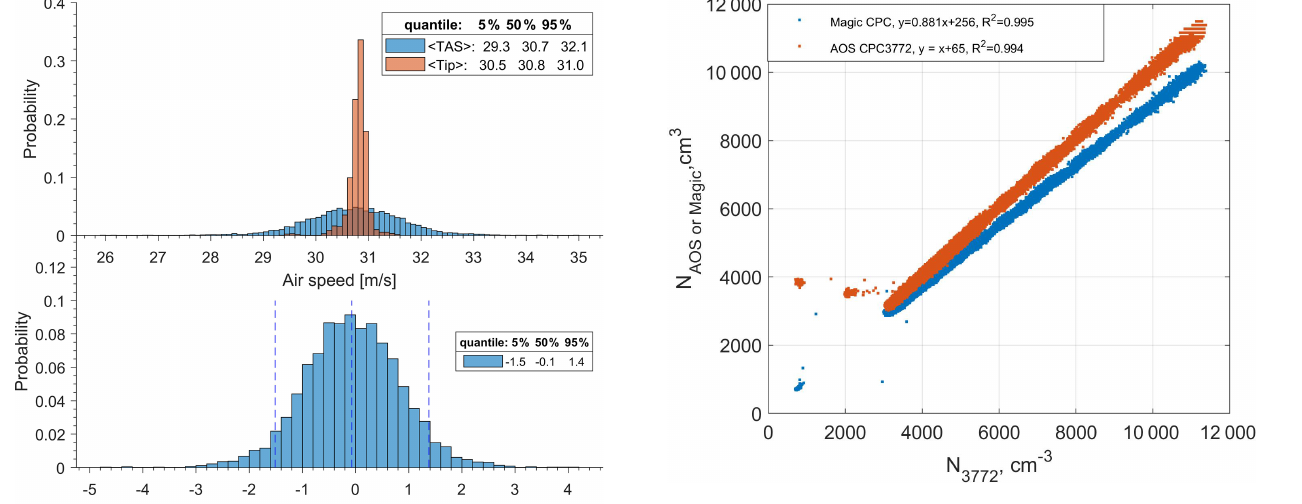
Figure 9. Aerosol total number concentration comparison between the AGMS CPC 3772, the Magic CPC against the AOS CPC 3772 at the ARM SGP observatory between 15 and 18 November